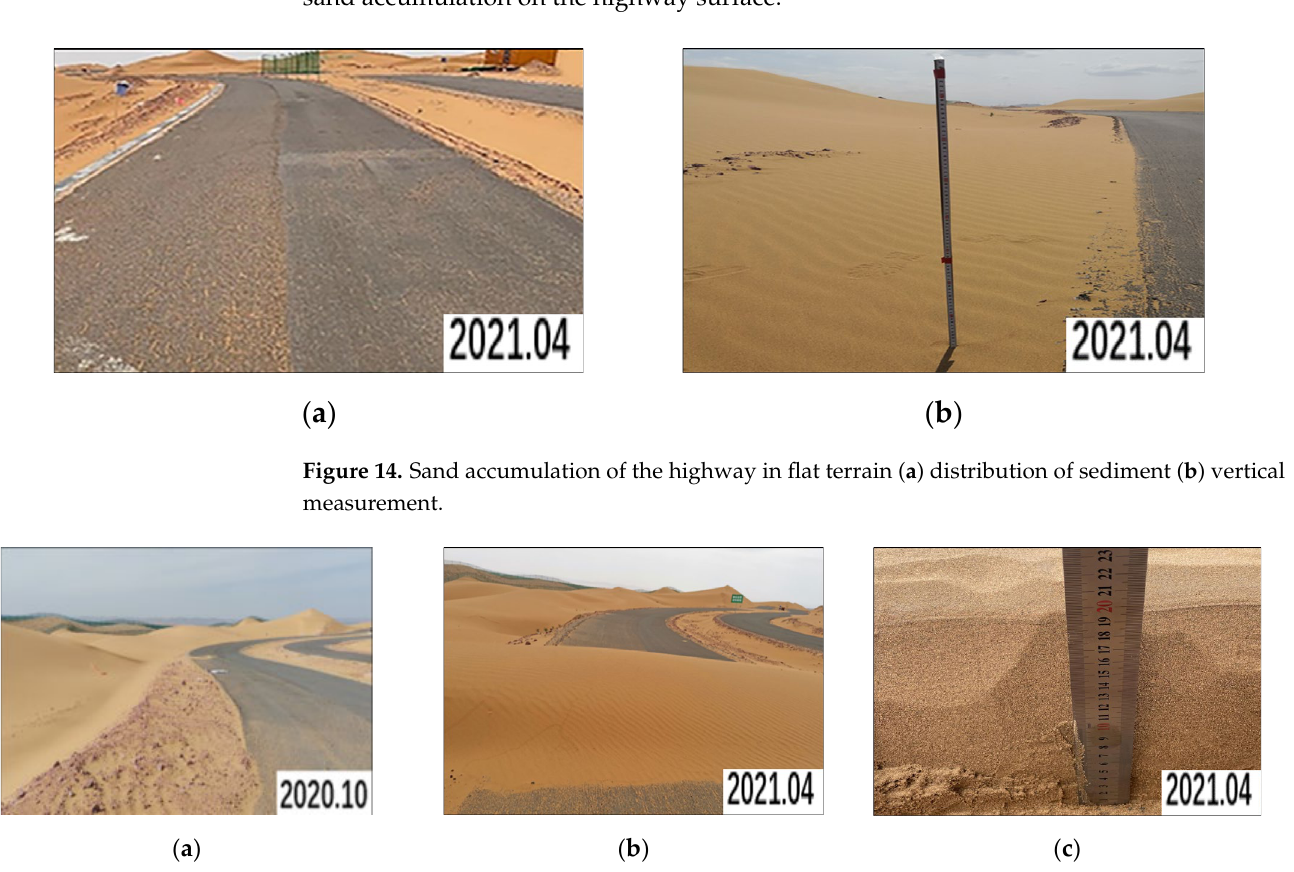
Figure 15. Sand accumulation of the highway on the dune’s windward side ( a ) sediment distribution in October 2020 ( b ) sediment distribution in April 2021 ( c ) scale measurement.